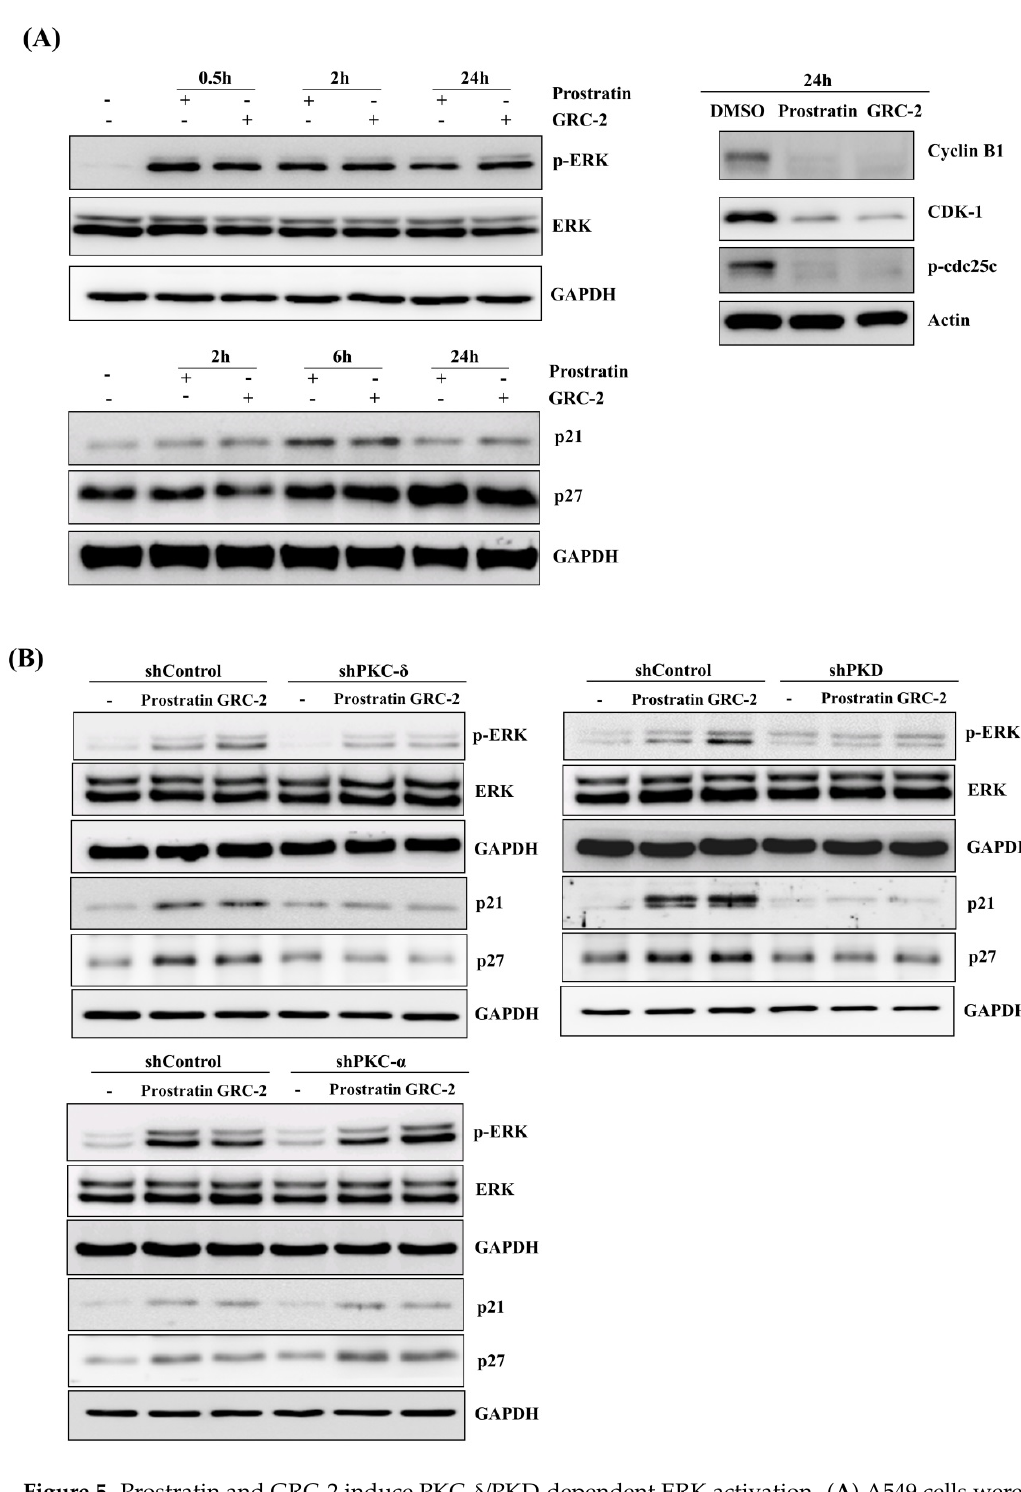
Figure 5. Prostratin and GRC-2 induce PKC- δ / PKD-dependent ERK activation. ( A ) A549 cells were treated with DMSO, prostratin (3 µ M), or GRC-2 (300 nM) for indicated periods. Minus (-) indicates no treatment and plus ( + ) indicates treatment with prostratin or GRC-2. Cells were harvested and subjected to immunoblotting for ERK, p21, p27, cyclin B1, CDK1, and p -cdc25c. ( B ) PKC- δ -, PKD-, or PKC- α knockdown cells were treated with DMSO, prostratin, or GRC-2 for 0.5 h (ERK) and 6 h (p21 and p27), respectively, followed by immunoblotting.